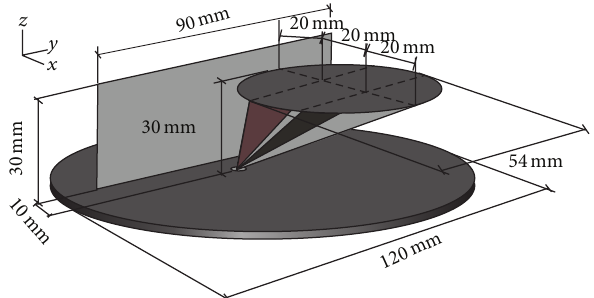
Figure 15: Semiplanar conical antenna with elliptical aperture and reflector.